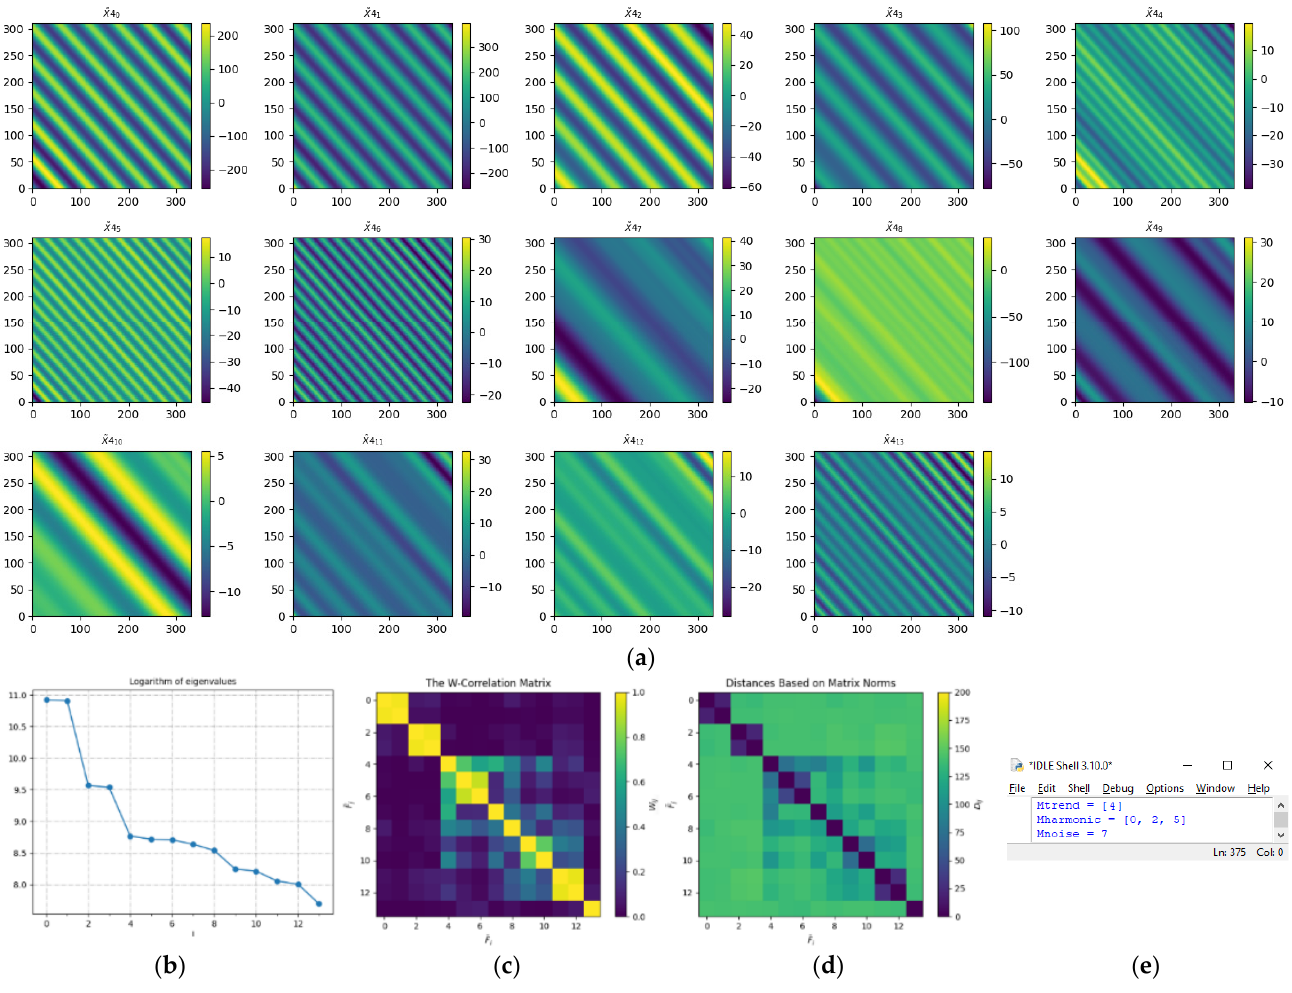
Figure A3. The result of matrix X4 decomposition and principal components analysis: ( a ) Hankelized principal components matrices; ( b ) the first 14 singular values of the trajectory matrix X4; ( c ) w-correlation matrix of distances between pairs of principal components; ( d ) matrix of distances between pairs of principal components based on the Frobenius norm; and ( e ) the result of the proposed algorithm, where Mtrend is the list of indexes of the singular numbers corresponding to the trend, Mharmonic is the set of indexes of the first elements from the pair, and Mnoise is the index of the singular number from which the noise components begin.